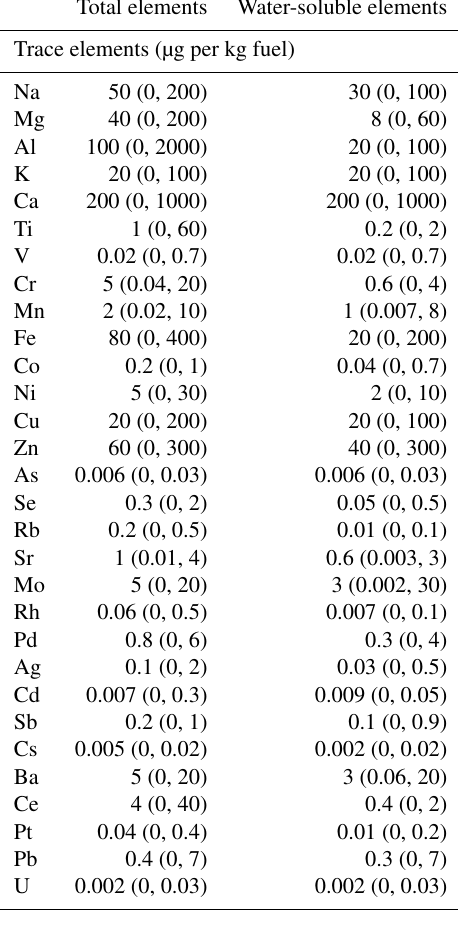
Table 1. Average of total trace total and water-soluble elements from car exhaust reported in EF (µg per kg fuel). These samples represent a range of different makes and models of cars. The values in parentheses are the range of the vehicle population ( n = 32).